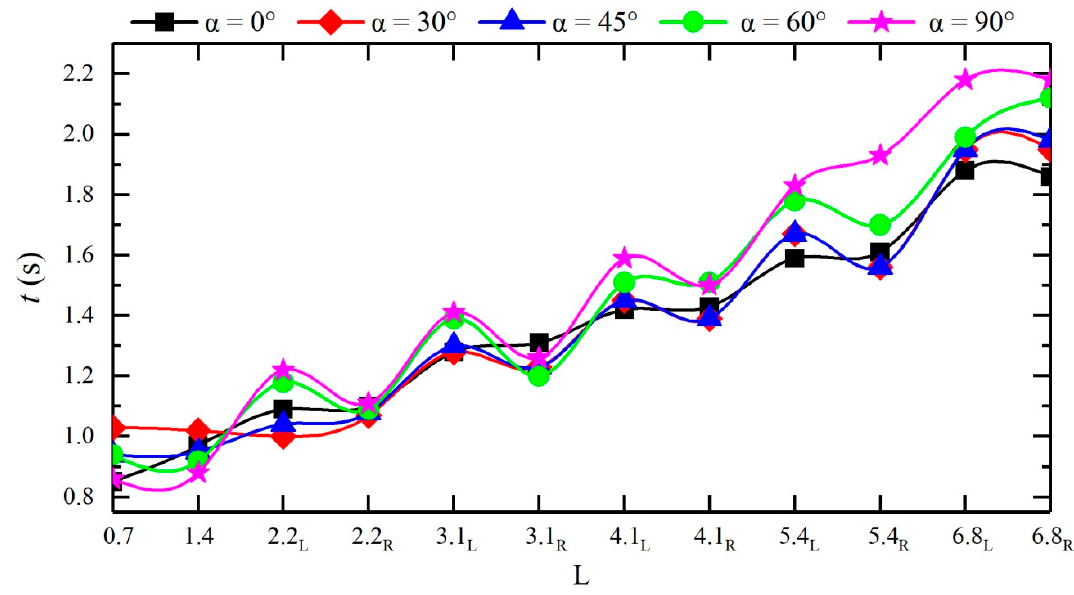
Figure 11. Water depth rise time t j at each measuring point of different configurations.